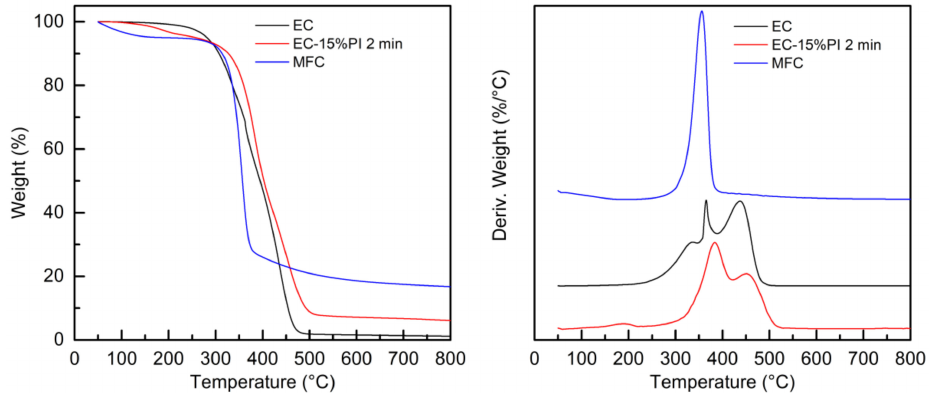
Figure 9. Weight (left), and first derivative (right) as function of temperature for the epoxidized cardanol resin EC, cured EC-15%PI resin, and dry MFC mat.